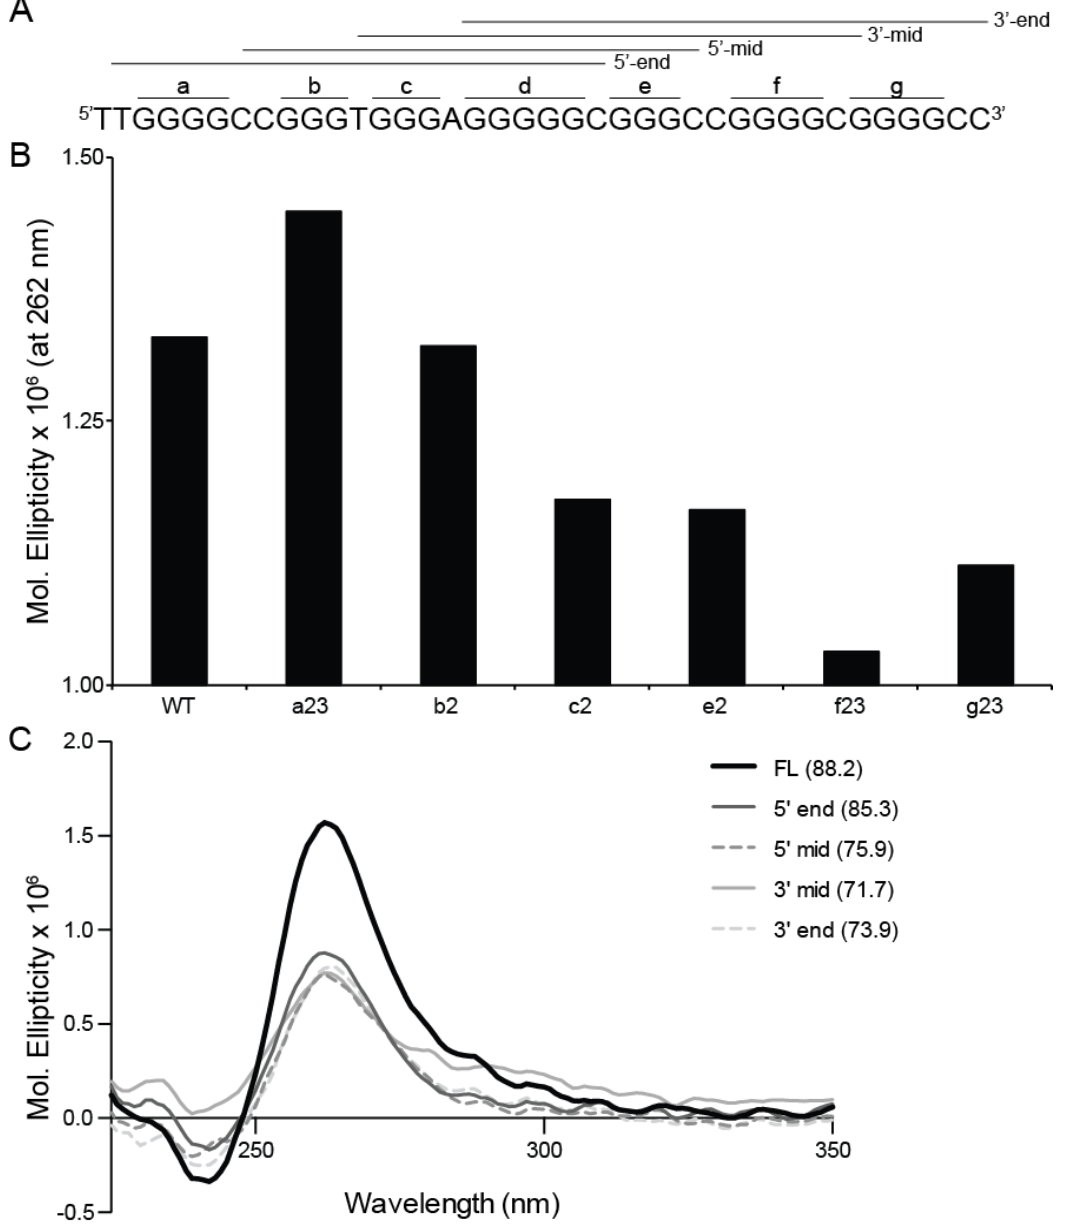
Figure 4. ( A ) Continuous runs of guanines in the 5'–3' ADAM-15 sequence were assigned sequential letters (a–g) and each run was mutated individually in the central 1 or 2 guanines (e.g., a23 indicates that the second and third guanine in the run of four were replaced with thymines) and used for further isoform analysis. Additionally, the sequence was truncated to the minimal sets of four contiguous runs of guanine as indicated by the 5'-end, etc ., indicated by the lines over the sequence. CD was performed in the presence of 100 mM KCl for the mutated ( B ) and truncated ( C ) sequences. In ( B ) the height of the parallel peak at 262 nm was compared from the WT to the mutant sequences, where it is evident that the mutations involving the 3' region impacted G4 formation to a greater extent. ( C ) Truncated oligos were all less stable (indicated by lower T s in the legend parentheses) with a M decreased molar ellipticity. Moreover, the 3'-mid sequence has an apparent antiparallel shoulder, which is taken into account for